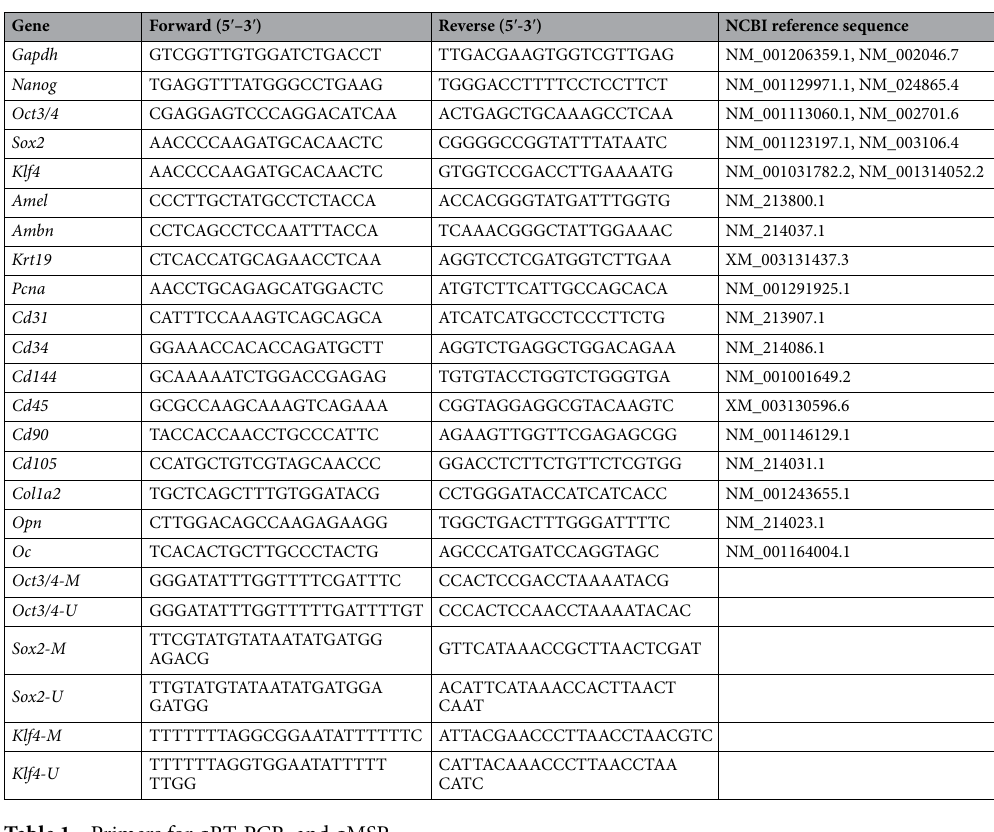
Table 1. Primers for qRT-PCR, and qMSP.